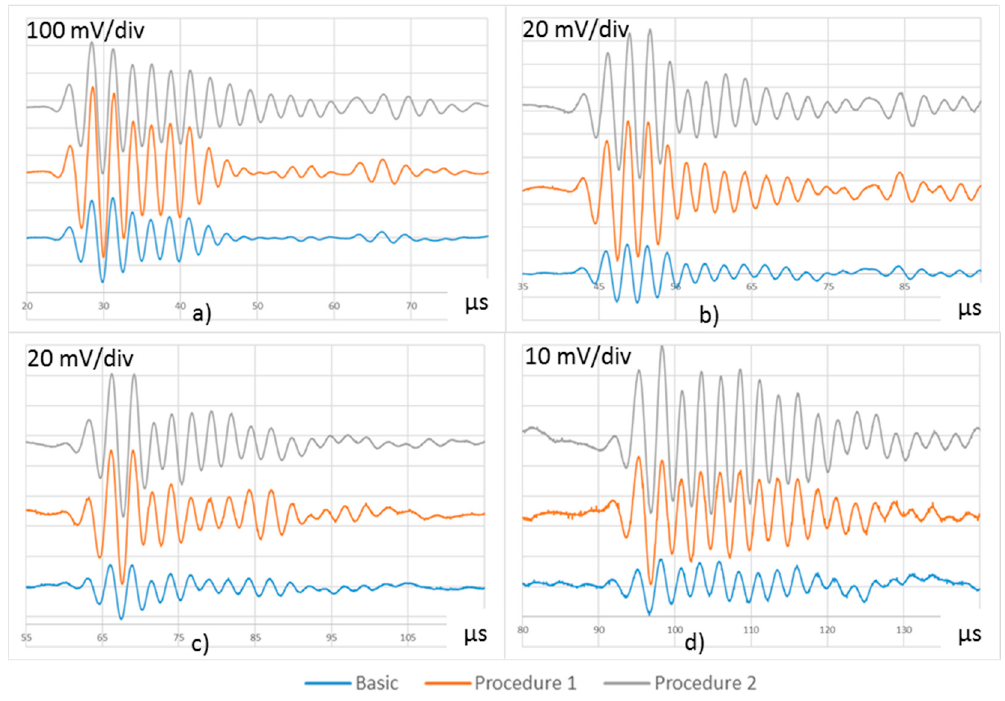
Figure 7. Waveforms acquired in ( a ) R1, ( b ) R2, ( c ) R3, and ( d ) R4 with the following